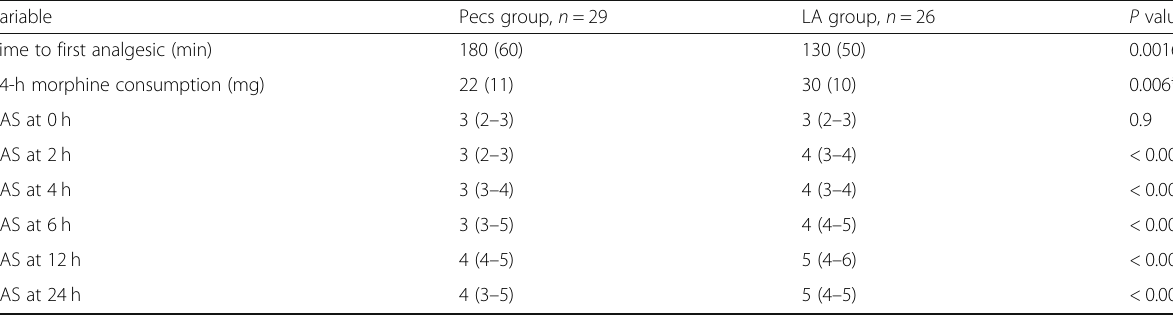
Table 3 Postoperative pain scores and analgesic consumption